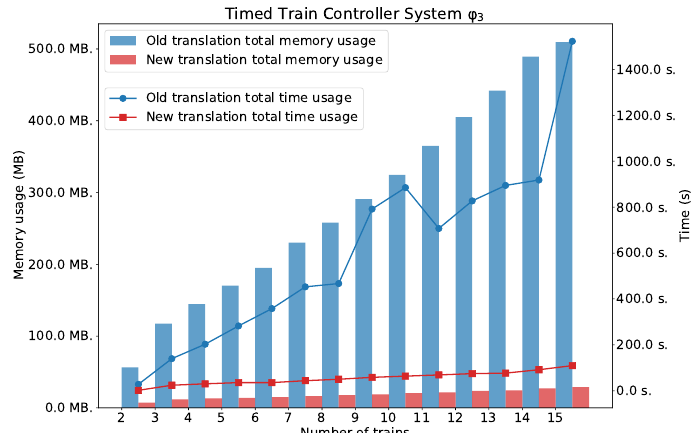
Figure 13. ϕ 3 : TTCS with n trains.